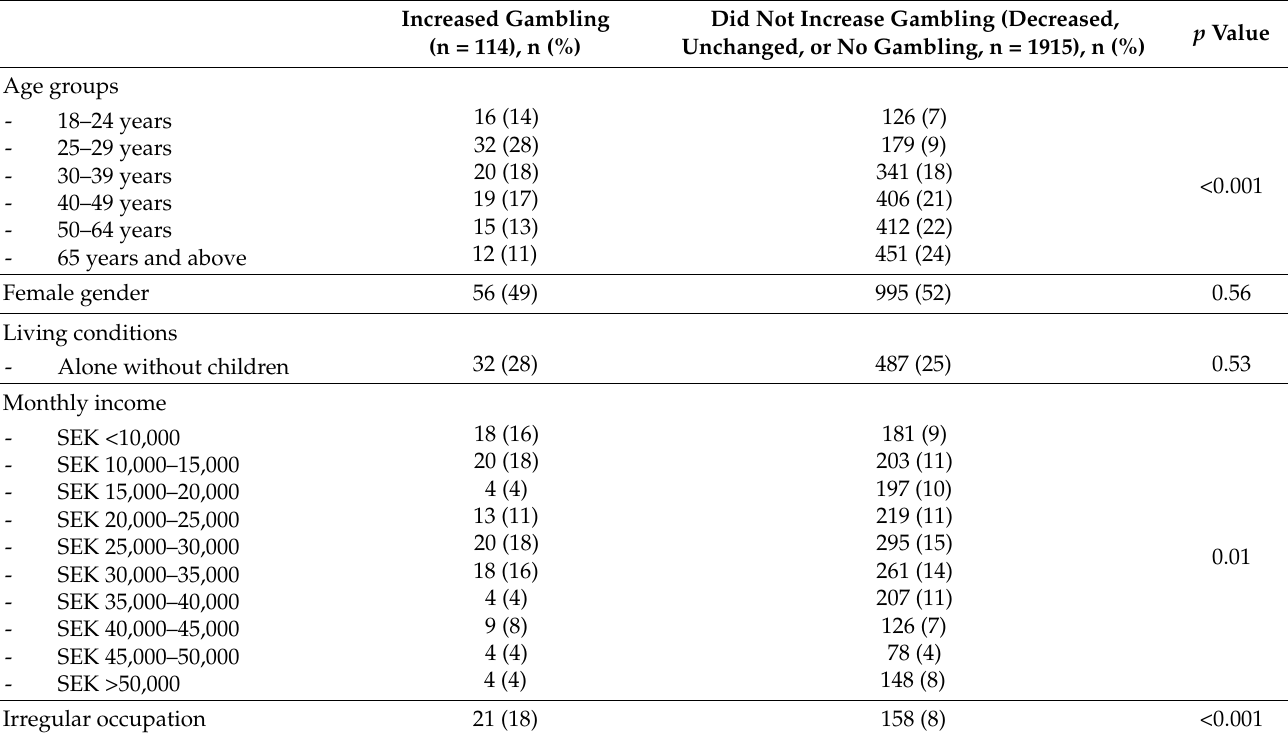
Table 3. Comparison of respondents with increased gambling and respondents with decreased, unchanged, or no